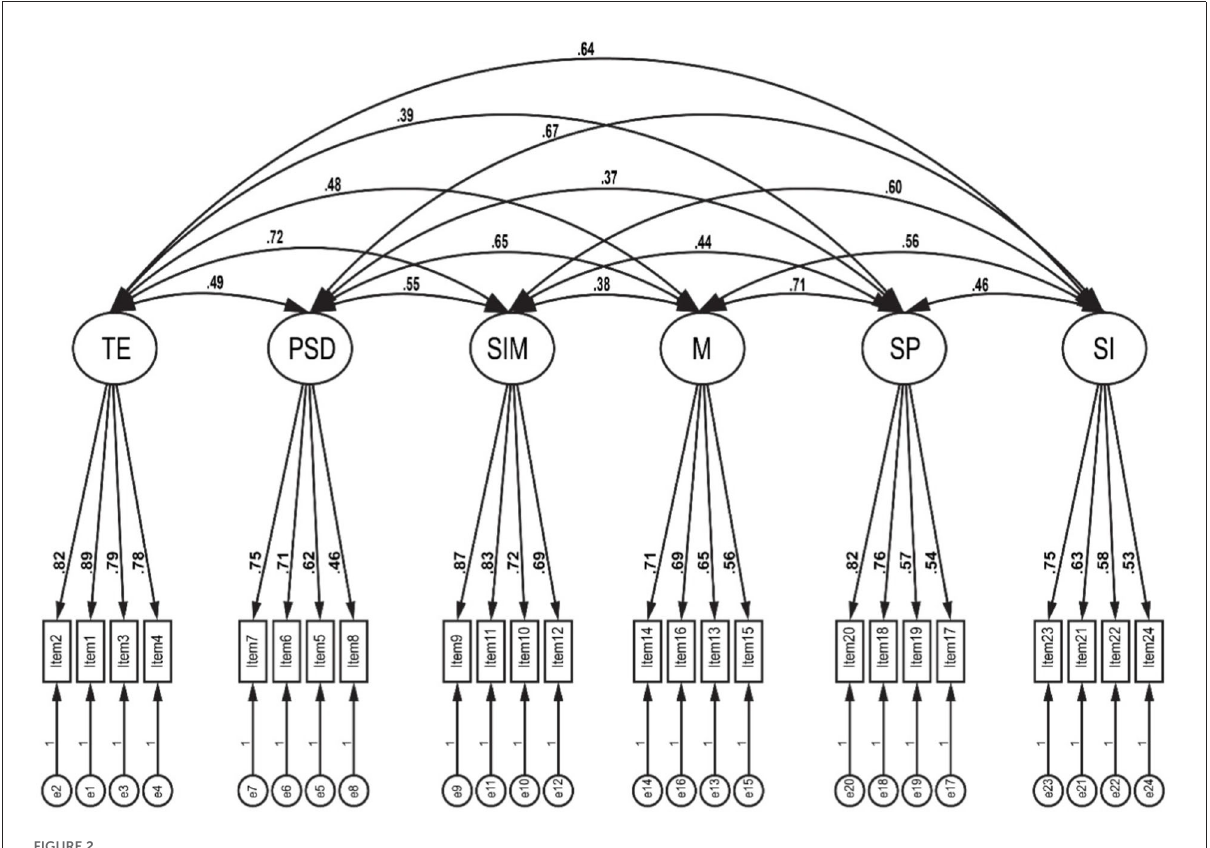
FIGURE2 Measure structure